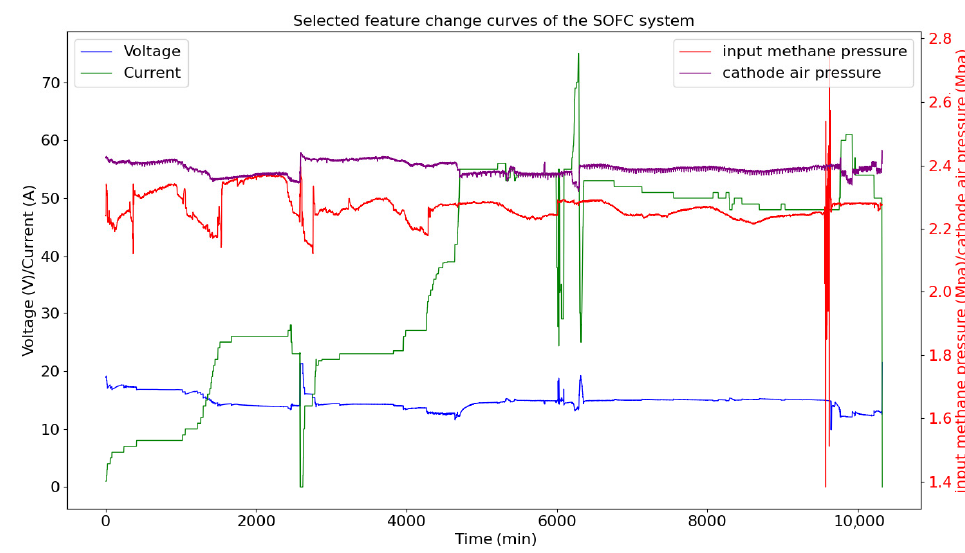
Figure 7. Selected feature change curves of the SOFC system.